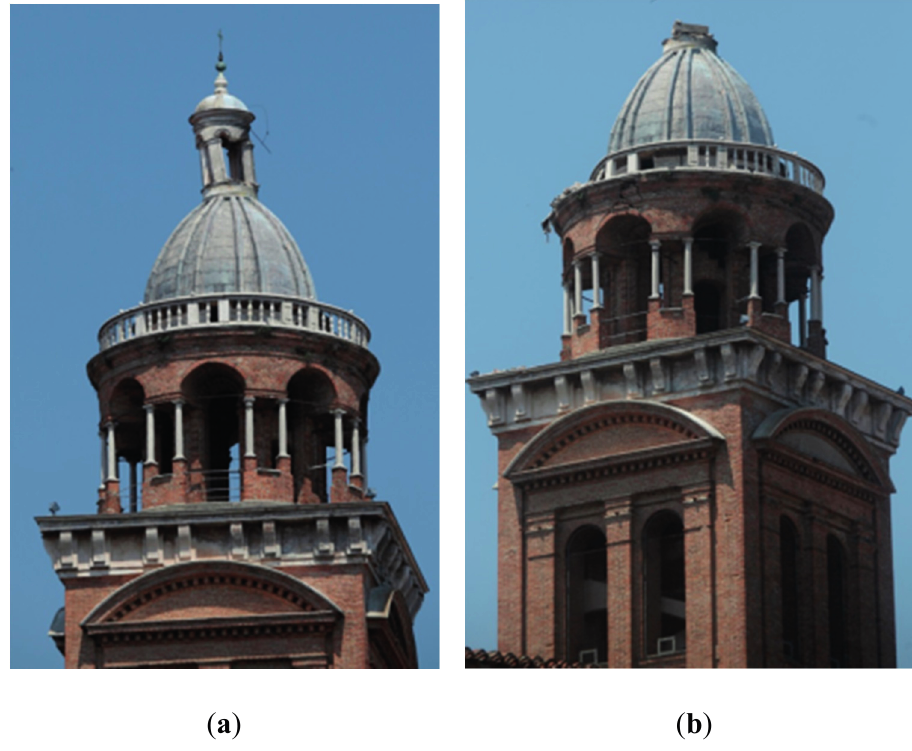
Figure 2. Santa Barbara bell tower, after the first earthquake ( a ) and the second ( b ) with the collapse of the